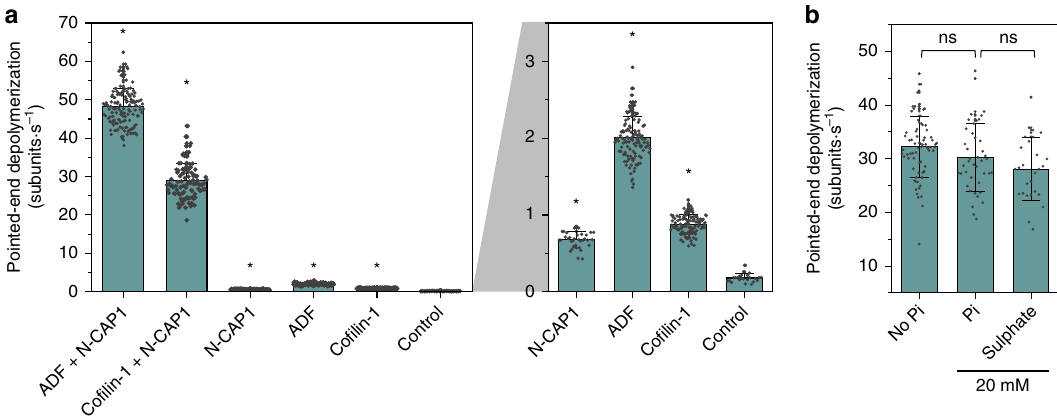
Fig. 3 Synergistic depolymerization across species and effect of chemical environment. a Rates (±sd) of depolymerization in the presence of 5 μ M human ADF or Co fi lin-1 and/or 0.83 μ M N-CAP1. Statistical comparison: ns no evidence for signi fi cance at p = 0.05 by two-sample t test against Srv2 + Cof1 condition. Right, magni fi ed view. *statistical comparison by two-sample t test against Control ( p < 0.05). Number of fi lament ends analyzed for each condition (left to right): 144, 103, 37, 130, 128, 24 and 103. b Rates (±sd) of pointed-end depolymerization by 1 μ M Cof1 and 0.5 μ M N-Srv2 in absence and presence of 20 mM P i and 20 mM K 2 SO 4 . Statistical comparison: ns no evidence for signi fi cance at p = 0.05 between the indicated conditions by two- sample t tests. Number of fi lament ends analyzed for each condition (left to right): 73, 42 and 27. Source data are provided as a Source Data fi le. All experiments were performed at least three independent times, and yielded similar results. Data shown are from one